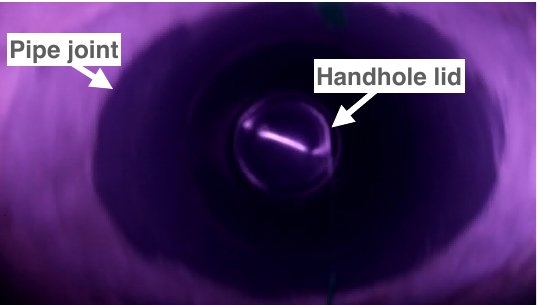
Figure 7. Example of a video frame captured at the bottom of a utility hole.